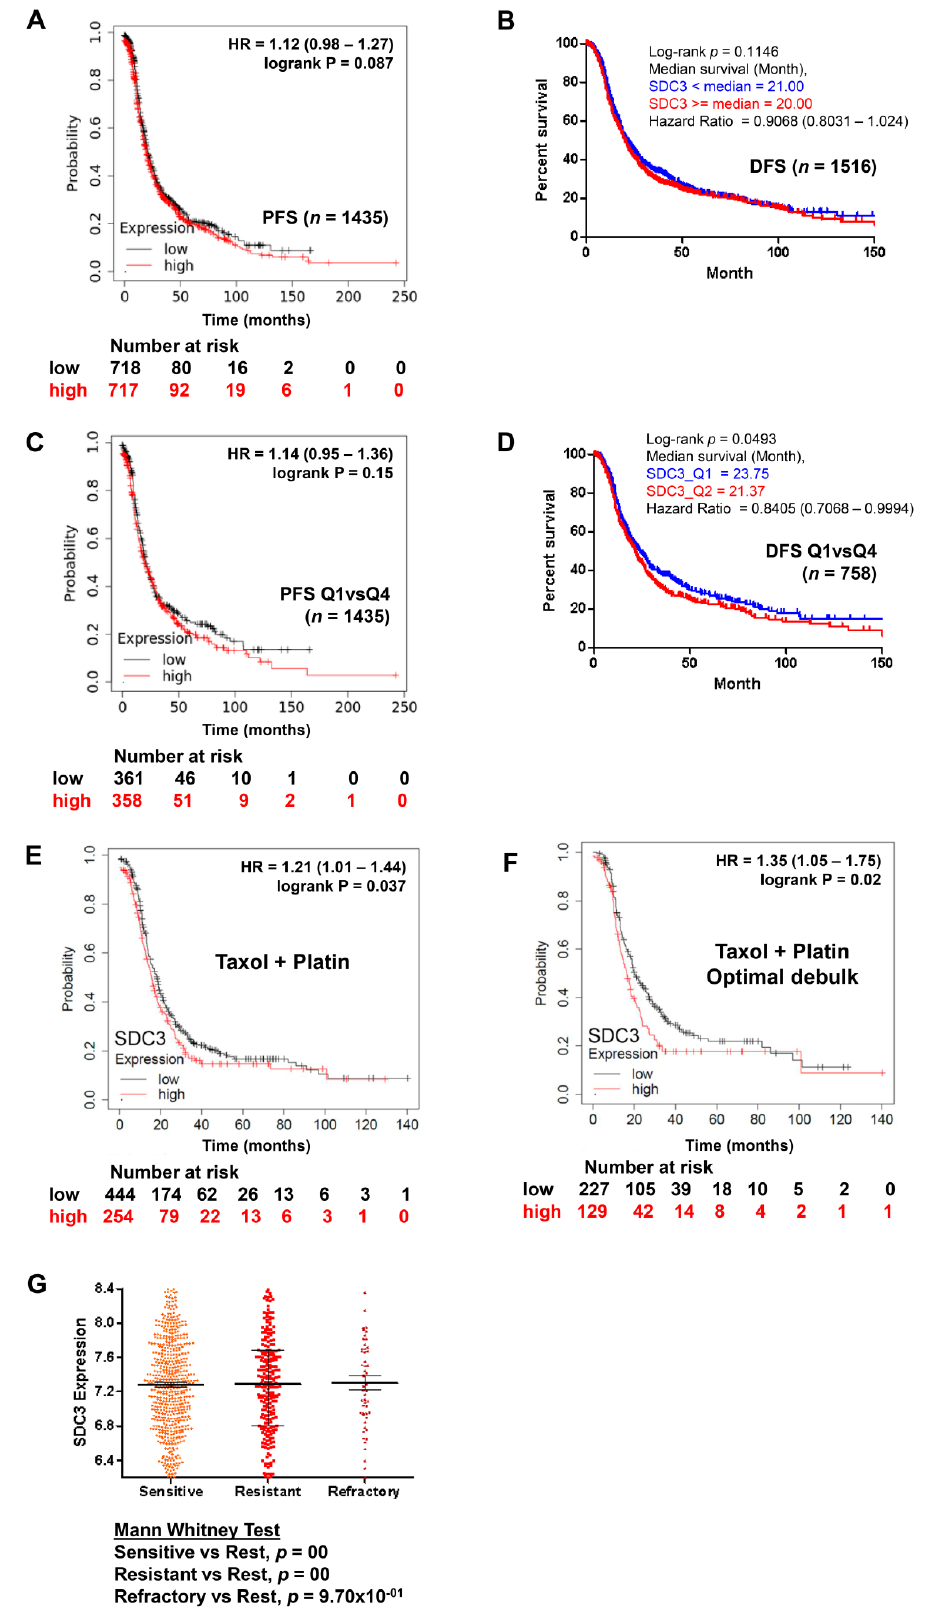
Figure 4. Kaplan–Meier survival analysis. ( A ) all patients, ( C ) Quartile 1 and Quartile 4 expression of SDC3 in ovarian cancer patients. ( E ) Ovarian cancer patients with high compared with low SDC3 mRNA expression in tumor tissue in patients subjected to Taxol and platinum